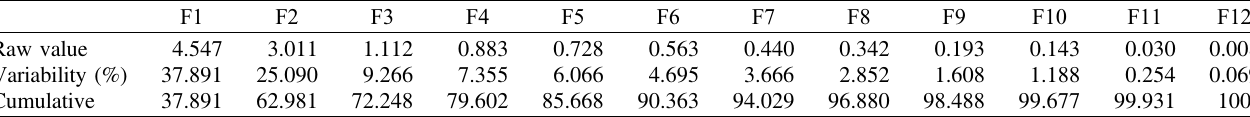
Table 5. Principal component analysis results (raw